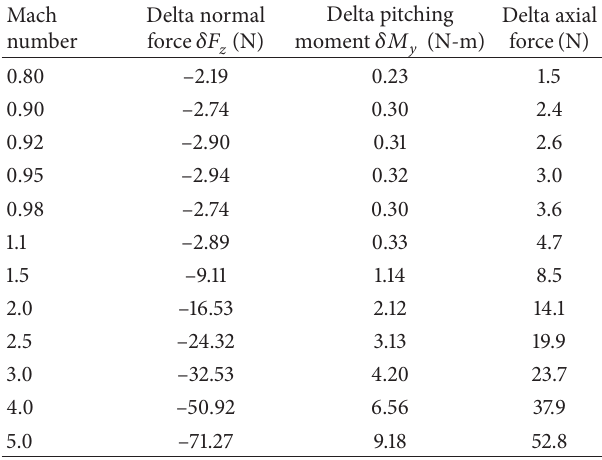
Table 8: Delta forces and moments due to microflaps, no fins, 𝛼 = 0 ∘